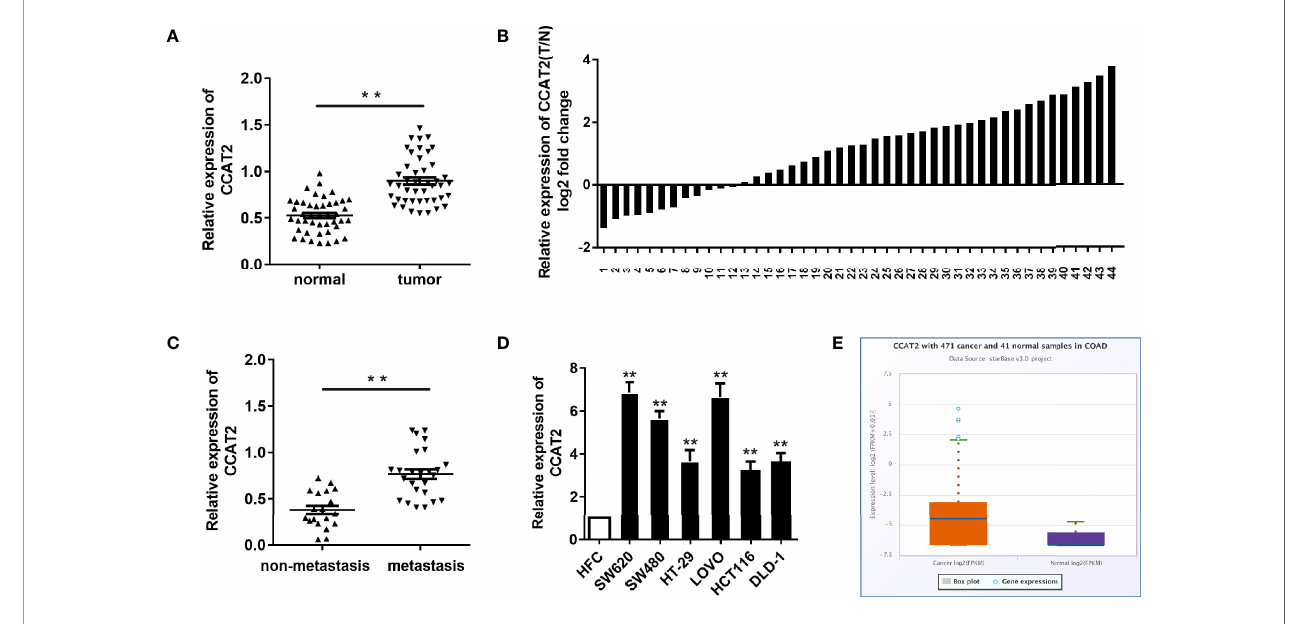
FIGURE 1 | CCAT2 expression was upregulated in CRC and associated with lymph node metastasis. (A, B) CCAT2 levels in CRC tissues and corresponding normal tissues from 44 patients were examined by qPCR. Data are shown as log2 of fold change in B. (C) The xpression of CCAT2 in CRC with lymph node metastasis or not was detected by qPCR. (D) The expression of CCAT2 was upregulated in the CRC cell lines (SW620, SW480, HT-29, LOVO, HCT116 and DLD-1) as compared to the normal colorectal epithelial cell line (HFC). (E) Expression of CCAT2 in CRC according to the TCGA Database. Boxplots were based on 471 colorectal cancer samples and 41 normal samples. The data are represented as mean ± SD. Three independent biological repeats were used for each analysis. *P < 0.05, **P < 0.01 vs